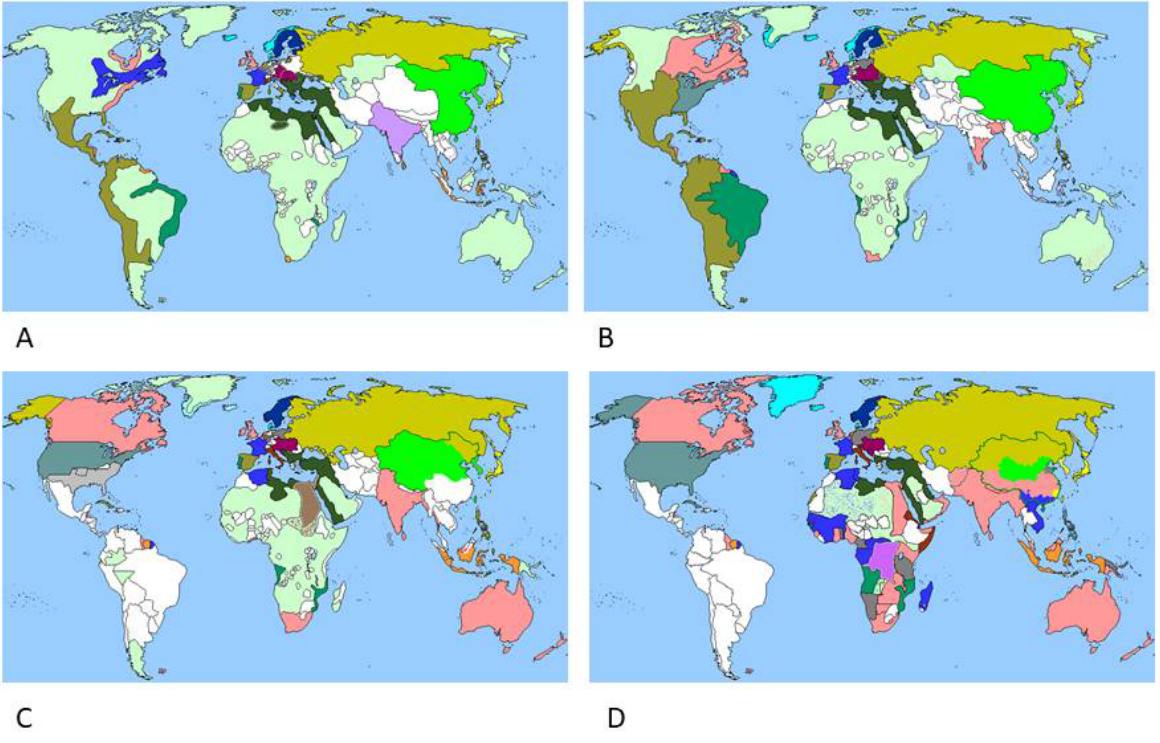
Figure 3. ( A ): World map 1660. A large part of South America was colonized by Spain (light green) and Portugal.(Green) Russia is dark blue ( B ): World map 1754. Almost all South America is colonized British colored red, whereas only tiny parts of Africa. ( C ): World map 1822. Even though Australia was known since 1606 it was not colonized until James Cook described the continent in 1770. ( D ): World map 1898. The major part of Africa is colonized and by 1914 all of Africa was colonized (Russia black, German and Belgium colonies blakc, Turkish colonies Light green , British colonies red, France colonies dark blue, Dutch colonies light red